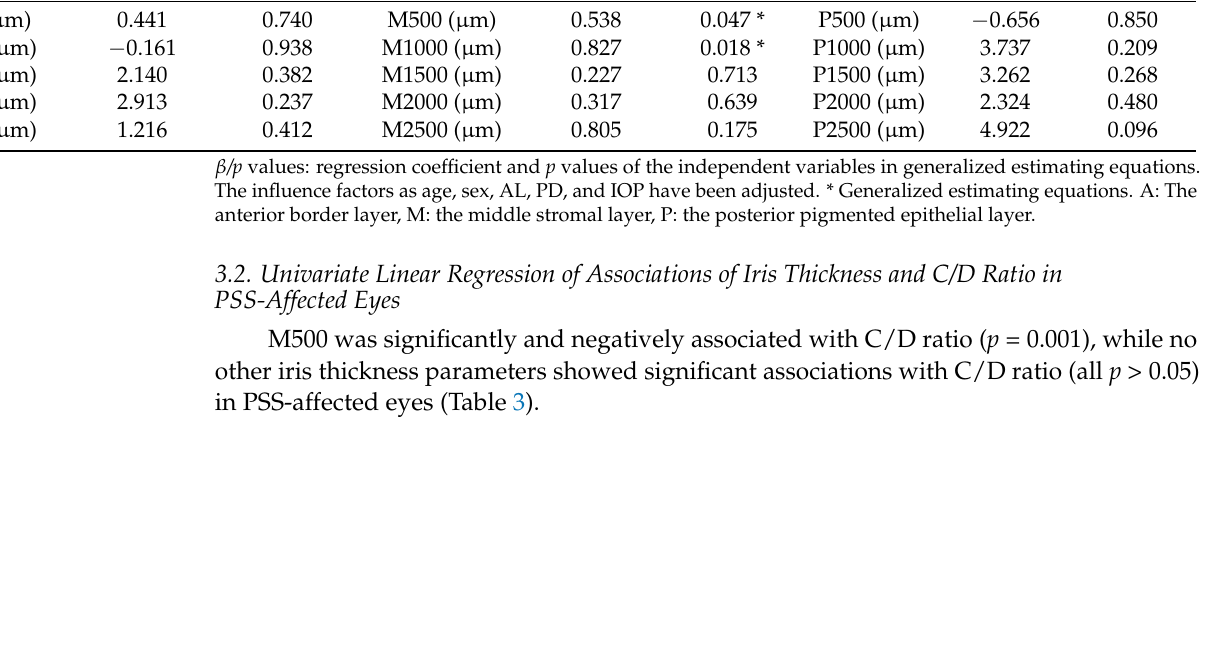
Table 3. Univariate linear regression of associations of iris thickness and C/D ratio in PSS-affected eyes.